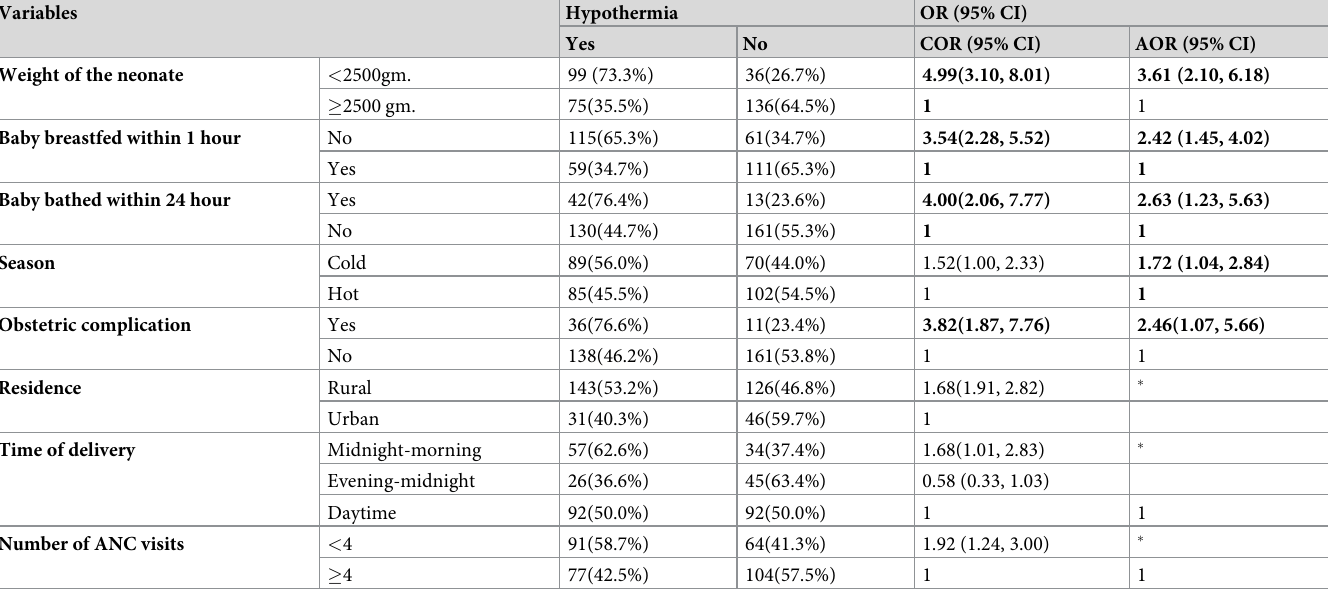
� = Not significant in stepwise backward logistic regression. (Wt. of the neonate p- value < 0.0001, Baby breast fed: p-value 0.001, Obstetric complication during pregnancy; p-value = 0.035, Season: p -value = 0.034, Baby bathed: p -value = 0.013.